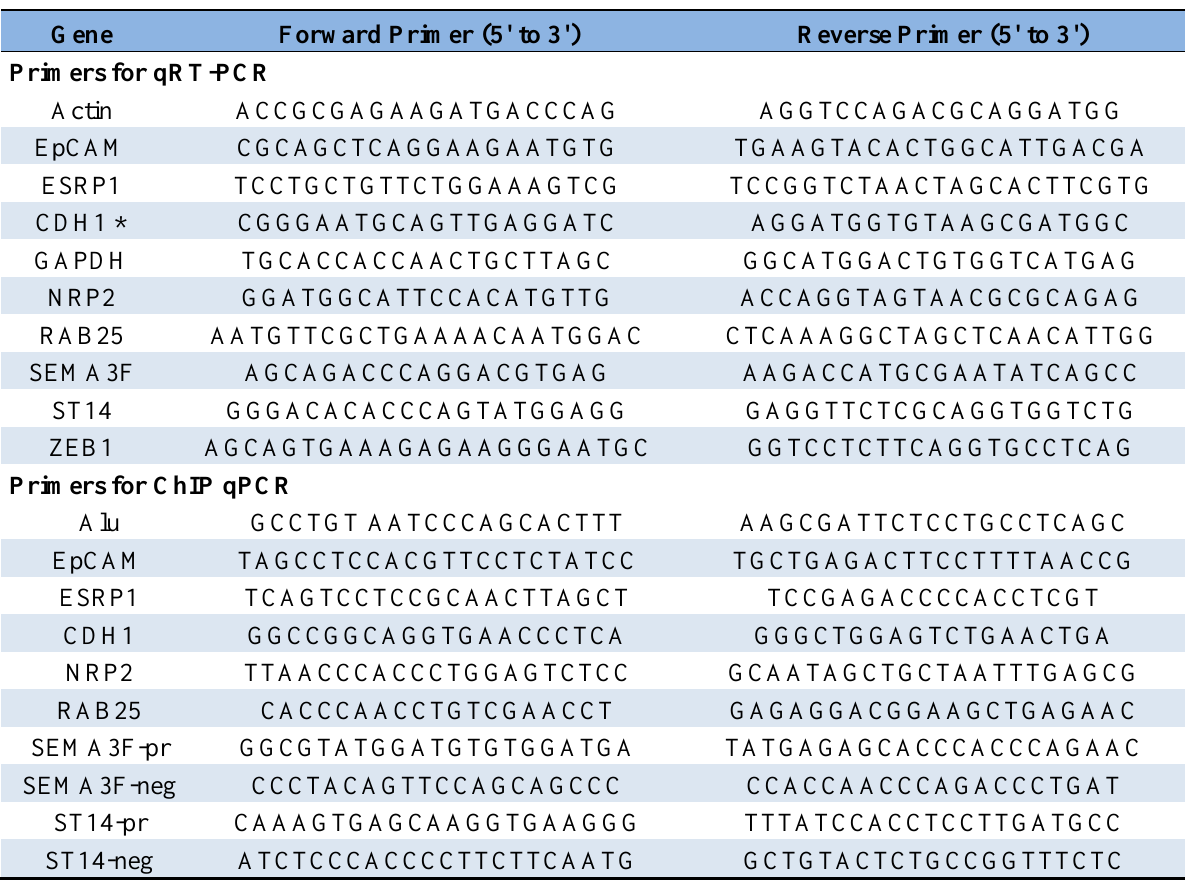
Table 1. Primers for